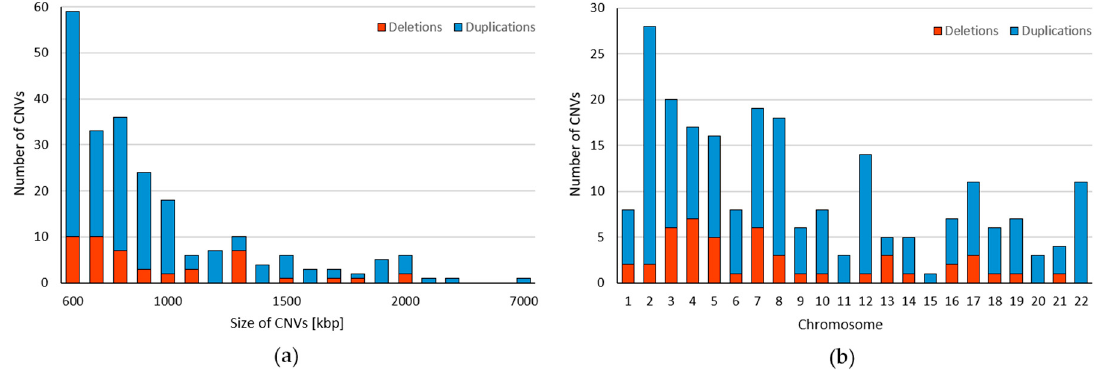
Figure 2. Characteristics of maternal CNVs identified from the NIPT. ( a ) Size distribution of detected CNVs ranging from ≥ 600 kbp to ≥ 7000 kbp. ( b ) Genomic distribution of CNV deletions (red) and duplications (blue) ≥ 600 kbp in Slovak population within the chromosomes. Table 1. Variants overlapping with CNVs that were previously observed among patients with pathogenic phenotypes. Data acquired from the ClinVar